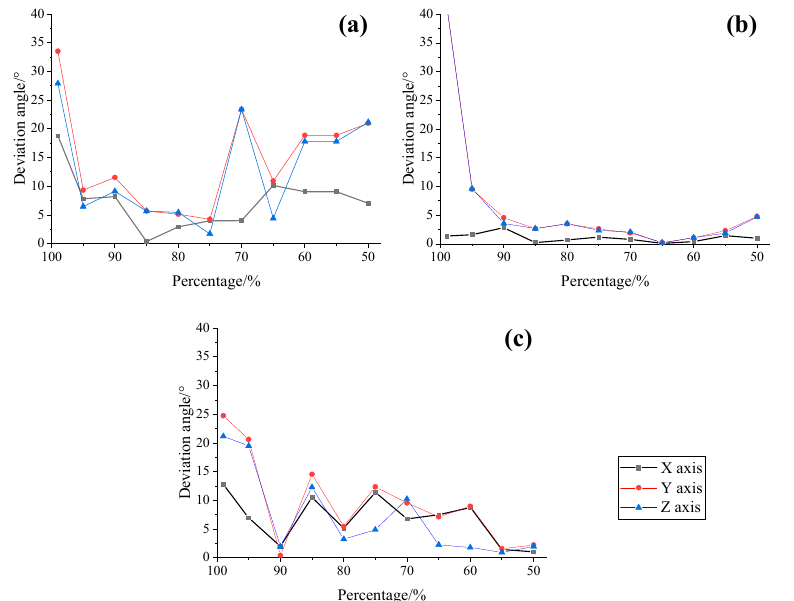
Figure 9. Results of deviation angle evolution. ( a ) Deviation angle evolution of Specimen S2. ( b ) Deviation angle evolution of Specimen S3. ( c ) Deviation angle evolution of Specimen S5.